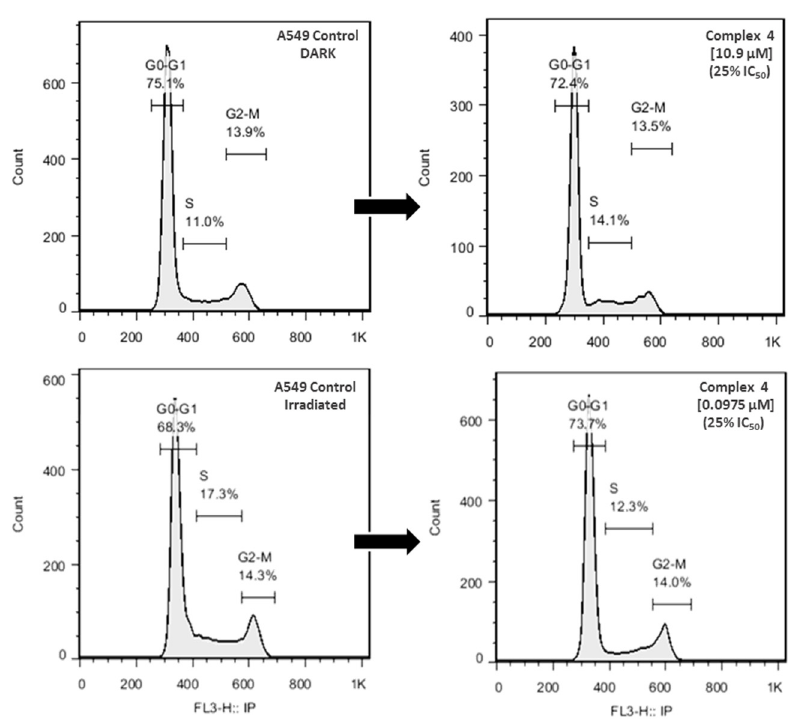
Figure 7. Cell cycle analysis after treatment with complex 4 in dark ( top graphs ) and under irradiation at 470 nm ( bottom graphs ). The cell distribution at each phase is indicated for each graphic.